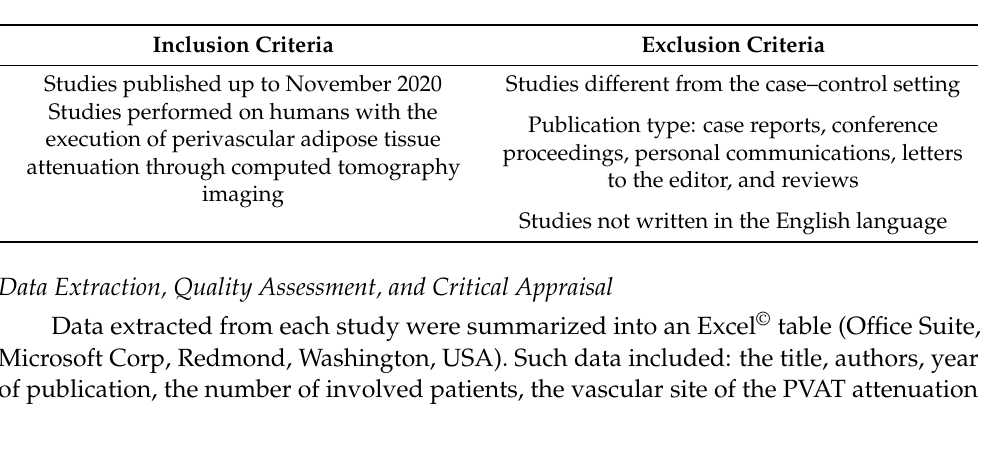
Figure 1. Flow-chart diagram for the selection of the 3 papers included in the review. Table 1. Inclusion and exclusion